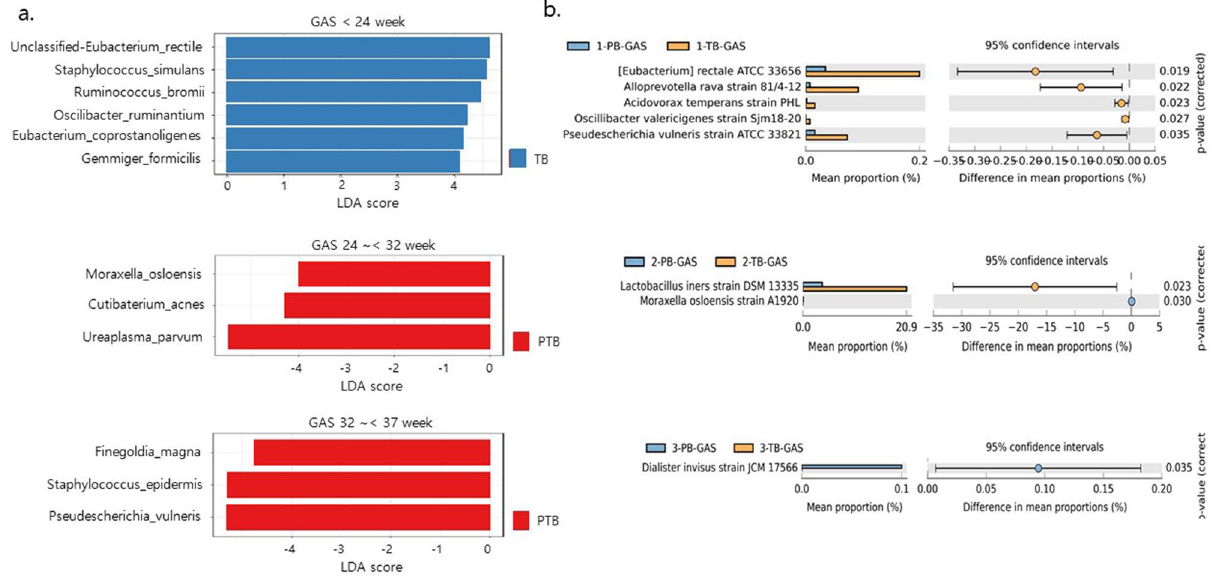
Figure 2. Comparative analysis of the vaginal microbiome in FTB and PTB. ( a ) FTB- or PTB-associated microbiome using linear discriminant analysis effect size, ( b ) differential abundance of the vaginal microbiome in women with FTB and PTB at each sampling time point. FTB Full-term birth, PTB Preterm